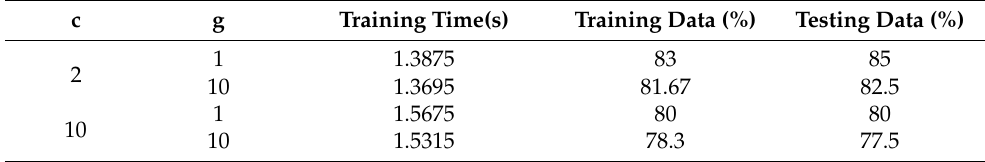
Table 5. Correction rate by SVM multi-classifier with PARAFAC.